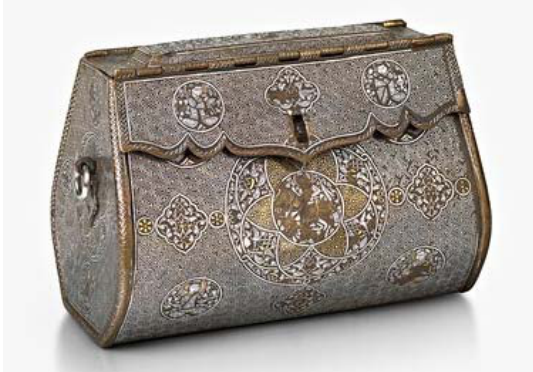
Figure 1. The Islamic ‘handbag’ at The Courtauld